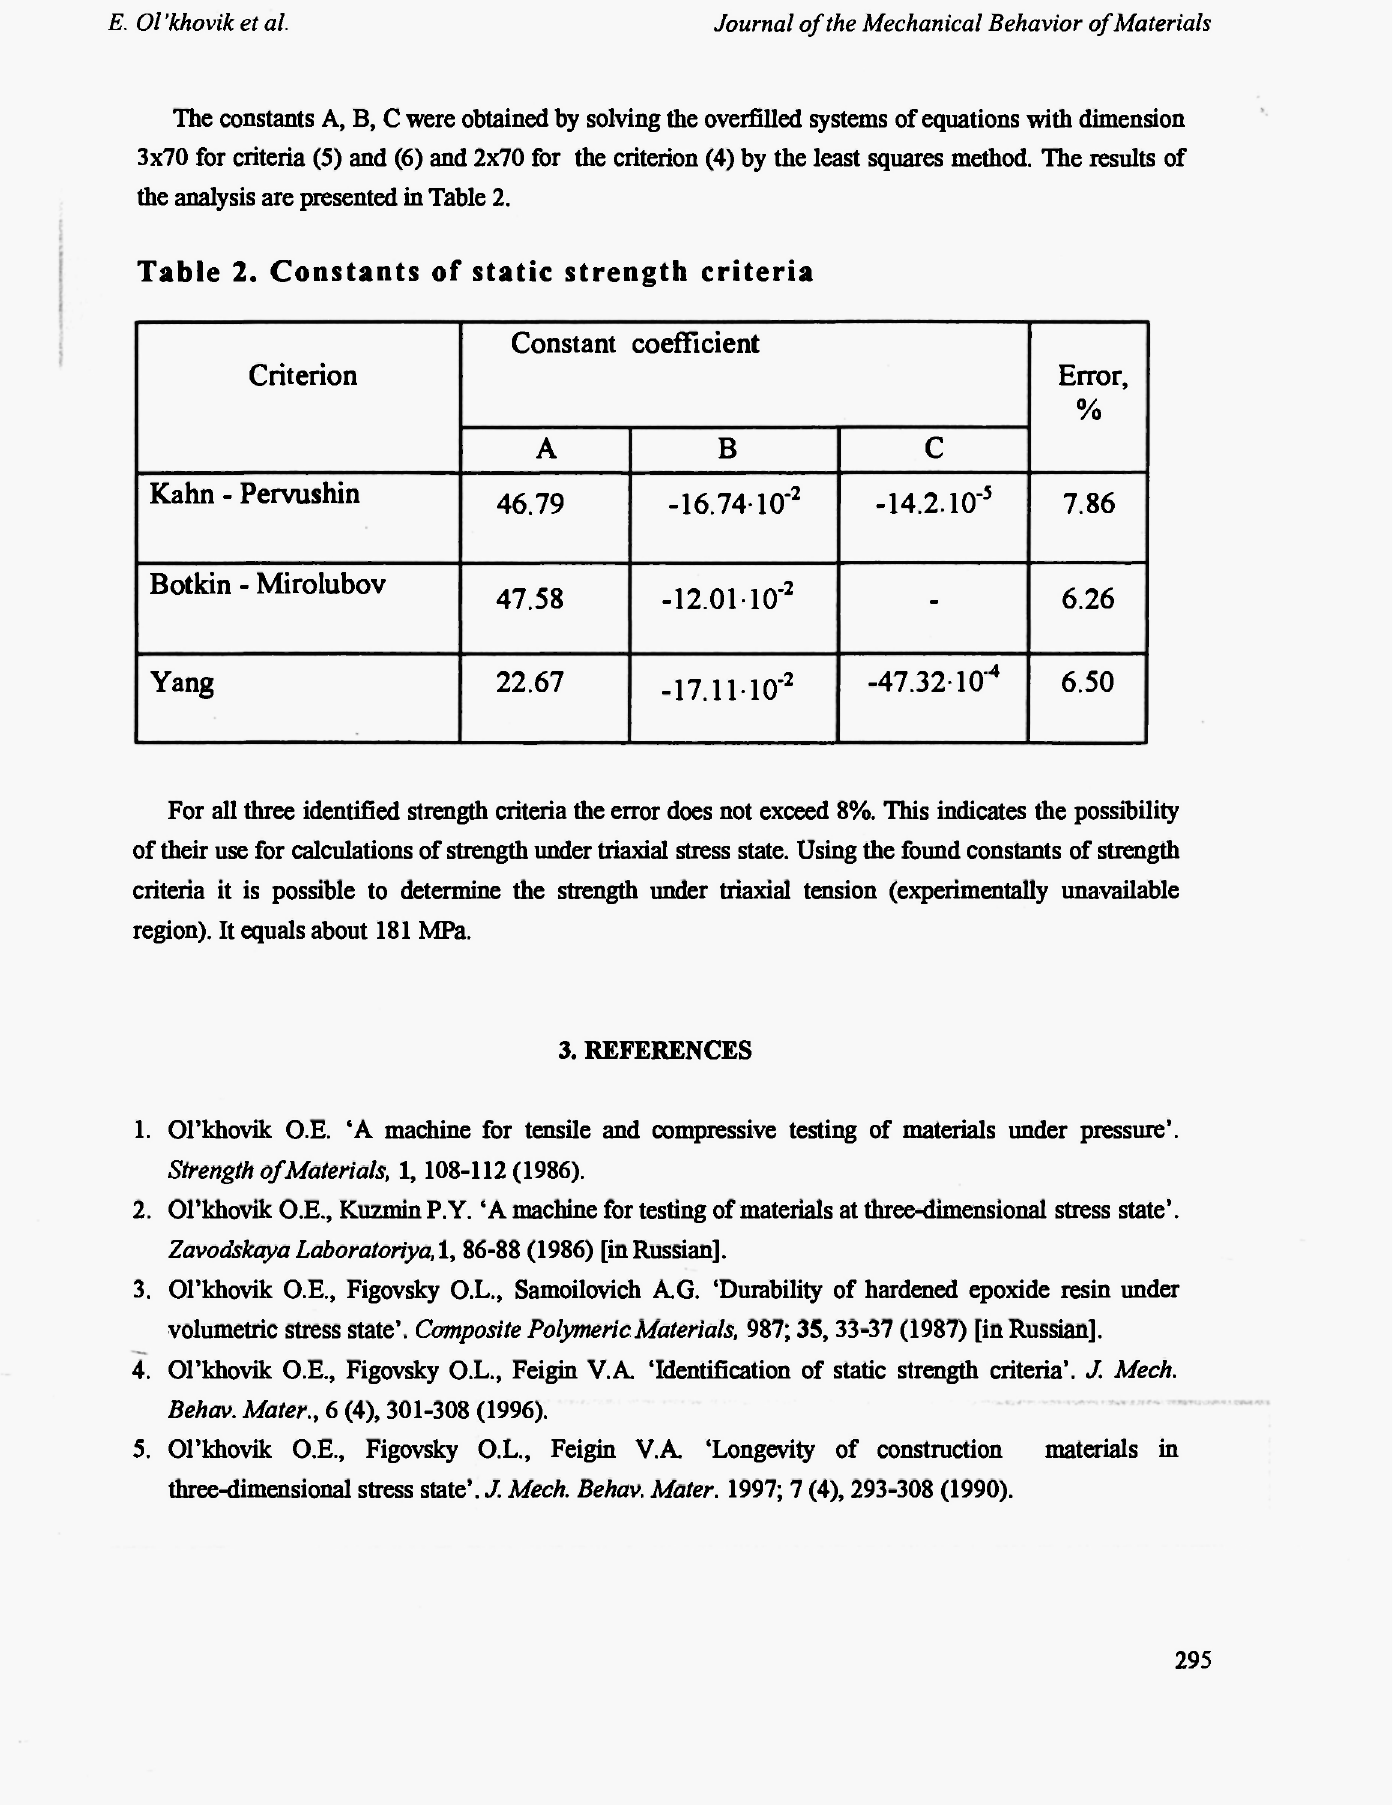
Table 2. Constants of static strength